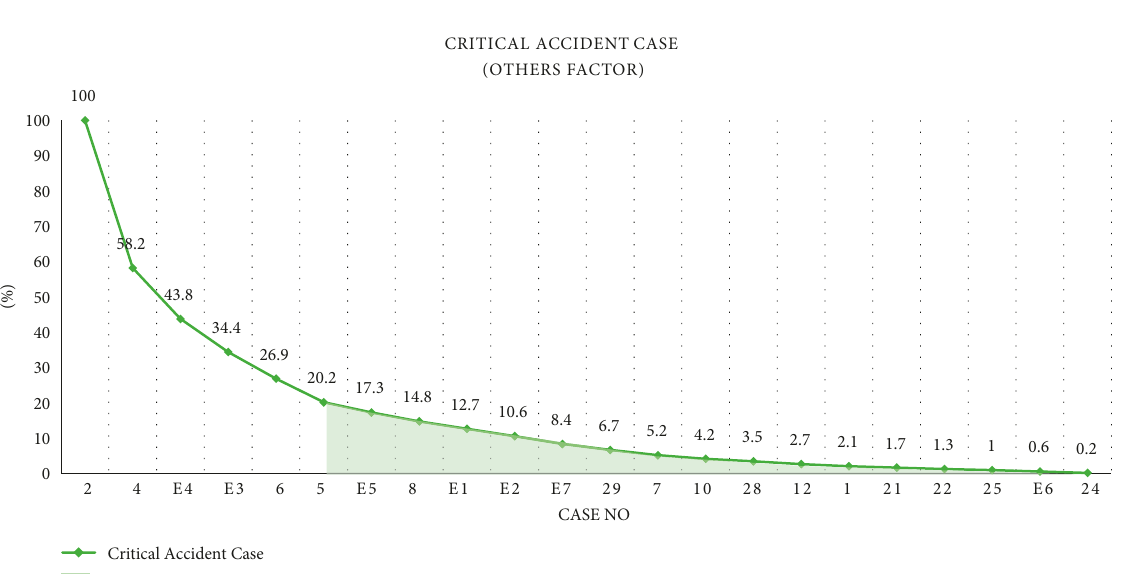
Figure 3: Edge case type of vehicle factors.